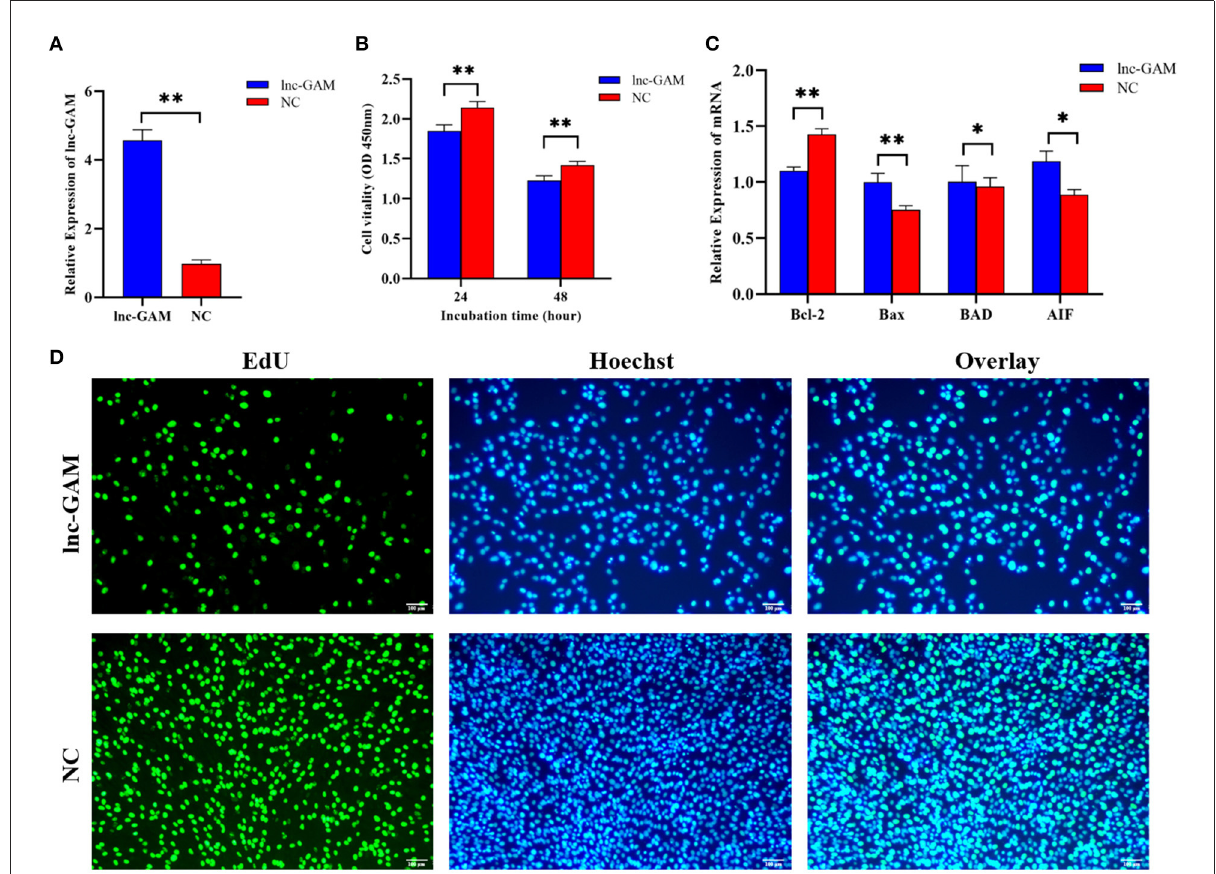
FIGURE8 Overexpression of lnc-GAM inhibited POGCs proliferation. (A) Graph showing the expression level of lnc-GAM in POGCs after transfection via RT-qPCR (* P < 0.05, ** P < 0.01, the same below). (B) Graph showing the viability of POGCs treated with lnc-GAM was measured by using CCK-8 at the indicated time points. (C) The mRNA levels of apoptosis-related factors were estimated by quantitative real-time PCR. GAPDH served as the internal reference. (D) Graphs showing the proportion of proliferation cells via EdU assay. The number of cells was detected by staining with Hoechst (blue), as the proliferated cells were detected by staining with EdU (green). The result was analyzed by fluorescence